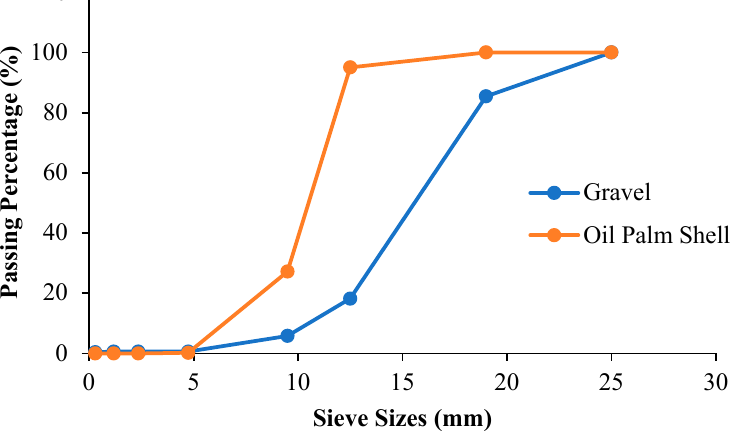
Figure 2. Comparison of the coarse aggregate grading of gravel and OPS.